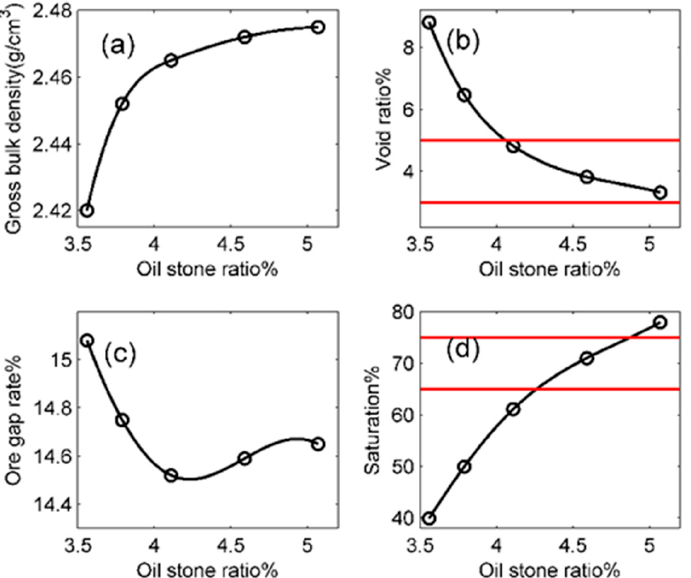
Figure 2. The optimum asphalt aggregate ratio. ( a ) The relationship between oil stone ratio and gross bulk density; ( b ) the relationship between oil stone ratio and void ratio; ( c ) the relationship between oil stone ratio and ore gap rate; ( d ) the relationship between oil stone ratio and saturation.